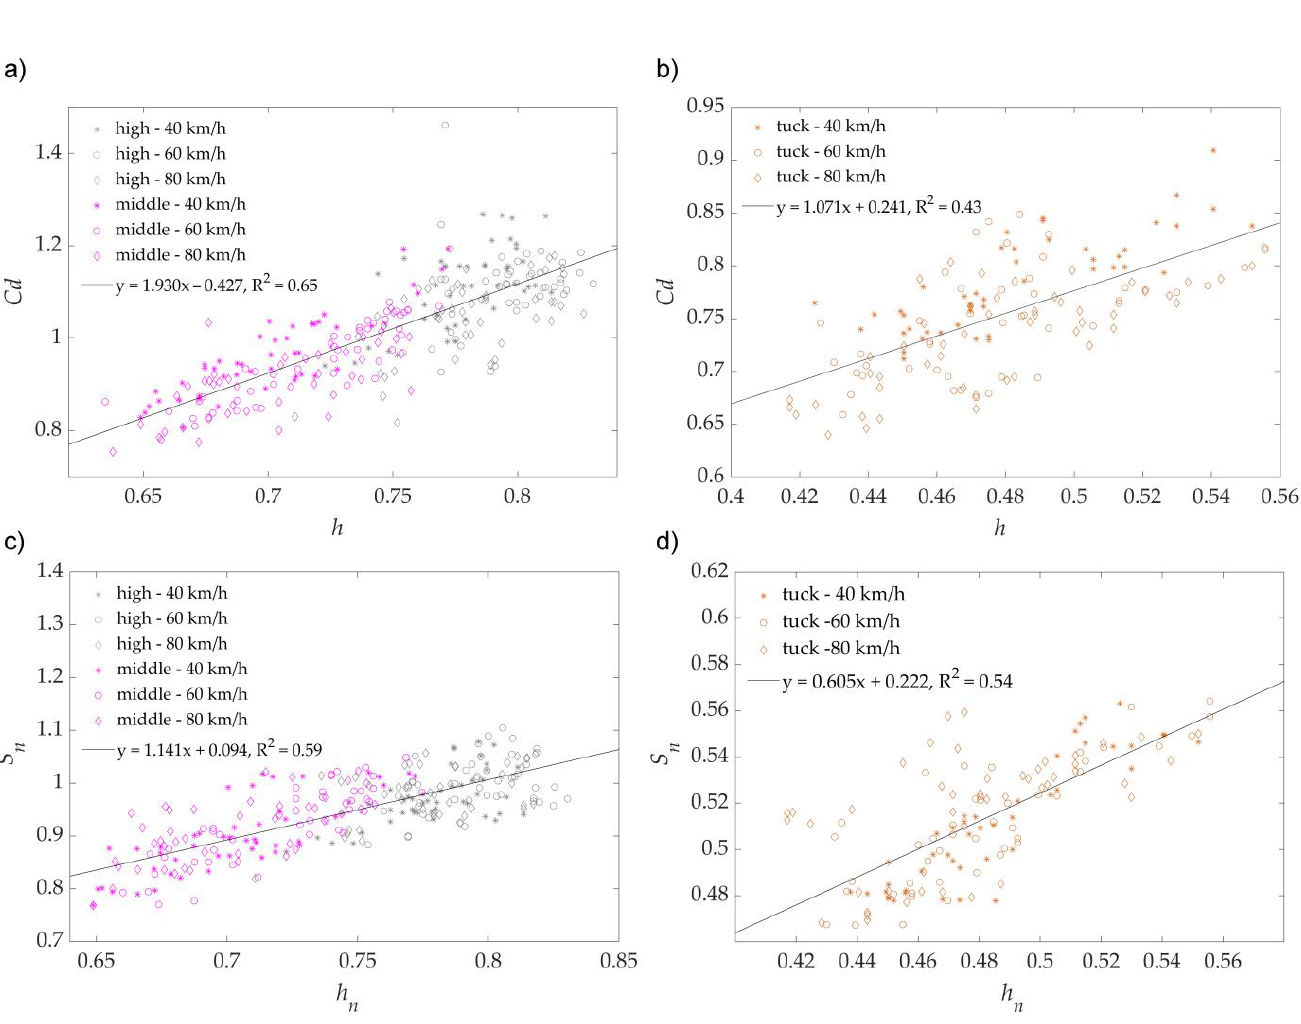
Figure 3. Linear regression model with R 2 values for the coefficient of the aerodynamic drag (C d ) and normalized cross- sectional area (S n ) as a function of normalized shoulder height (h n ): ( a , c ) in the high (violet) and middle positions (grey)), ( b , d ) in the downhill (tuck) position